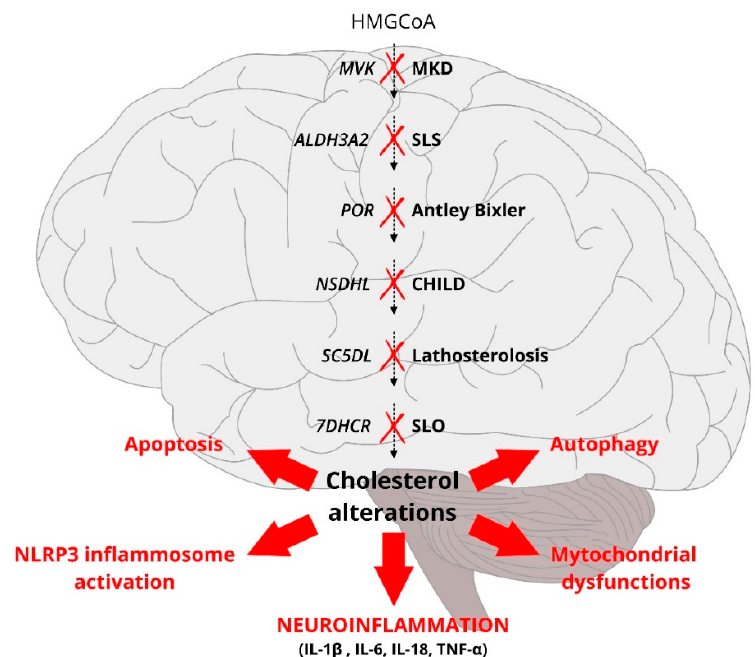
Figure 3. Cholesterol biosynthesis deficiency syndromes. Schematic representation of the cholesterol pathway and some cholesterol–deficiency syndromes in response to different enzyme defects along the metabolic pathway (indicated with red crosses). Despite different specific causes, all these syndromes share the involvement of the central nervous system, where cholesterol reduction causes NLRP3-inflammosome activation, apoptosis, mitochondrial dysfunctions, autophagy and neuroinflammation with interleukin secretion (IL-1 β , IL-18, IL-6 and TNF- α ). HMG-CoA: 3-Hydroxy- 3-MethylGlutaryl Co-enzyme; MVK : mevalotate kinase gene; MKD: Mevalonate Kinase Deficiency; ALDH3A2 : Aldehyde Dehydrogenase 3 Family Member A2 gene; SLS: Sjogren-Larsson syndrome; POR : Cytochrome P450 Oxidoreductase gene; Antley-Bixler syndrome-like phenotype with disordered steroidogenesis; NSDHL : NAD(P) Dependent Steroid Dehydrogenase-Like gene; CHILD: congenital hemidysplasia with ichthyosiform erythroderma and limb defects; SC5DL : Sterol-C5- Desaturase gene; Lathosterolosis; 7DHCR : 7-Dehydrocholesterol Reductase gene; SLO: Smith-Lemli- Opitz) syndrome; ; IL-1 β : Interleukin 1 beta; IL-6: Interleukin 6; IL-18: Interleukin 18; TNF- α : Tumor necrosis factor alpha.